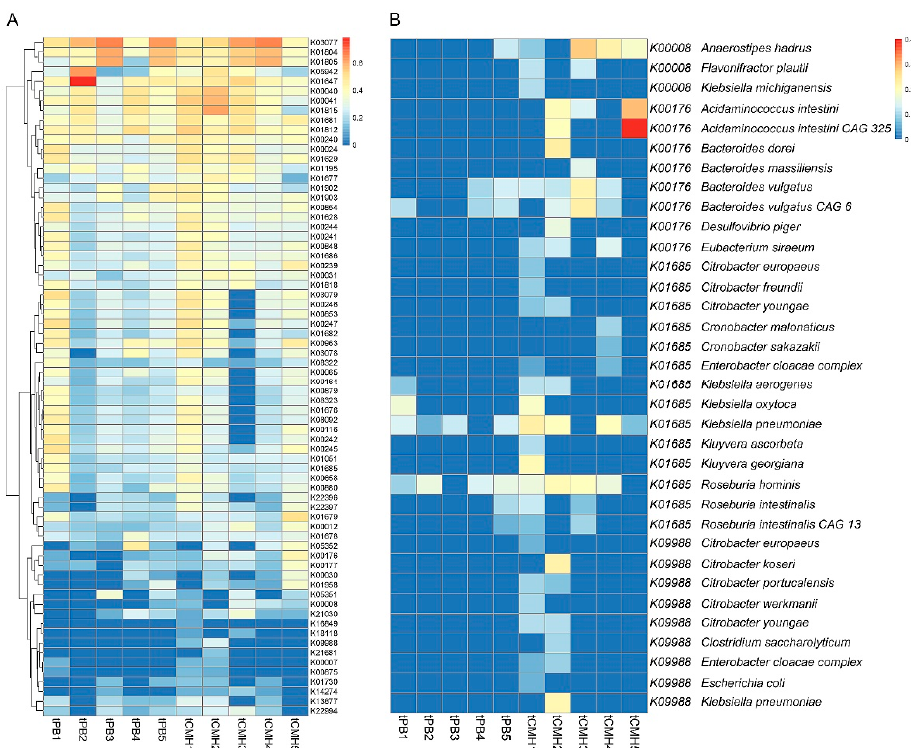
Figure 6. Heatmaps represent the enriched metabolic pathways underlying KO IDs ( A ) KO IDs involved in TCA cycle and pentose and glucuronate interconversions ( B ) Bacterial species underlying significant KO IDs. Note: Color maps display fourth root of RPKM value.